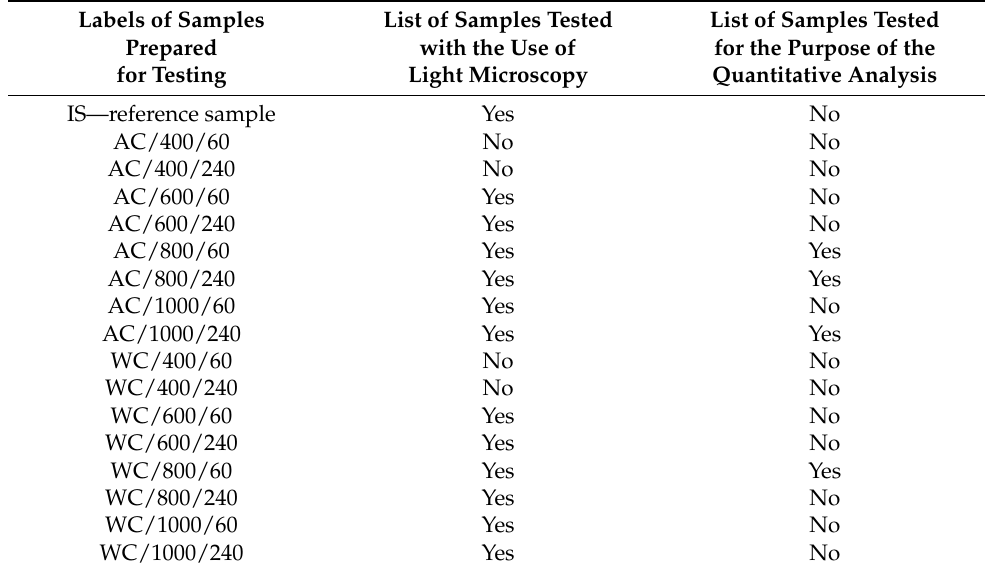
Table 1. List of tested